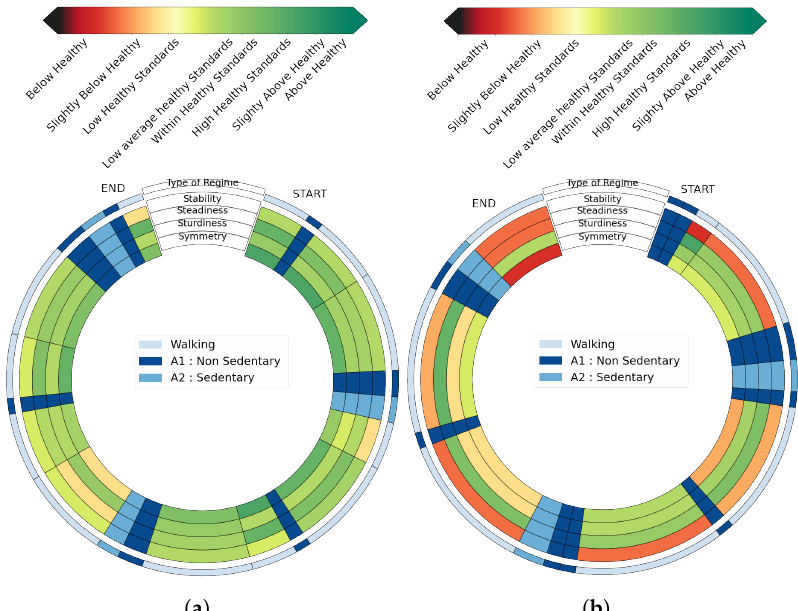
Figure 6. Evaluation of pre-hospitalization acquisition and post-hospitalization acquisition for a subject who has undergone knee ligamentoplasty. Post-operation evaluation displays a worse state. ( a ) Pathological Subject 3 graphical feedback Pre-surgery PSU3A ; ( b ) Pathological Subject 3 graphical feedback: Post-surgery PSU3B